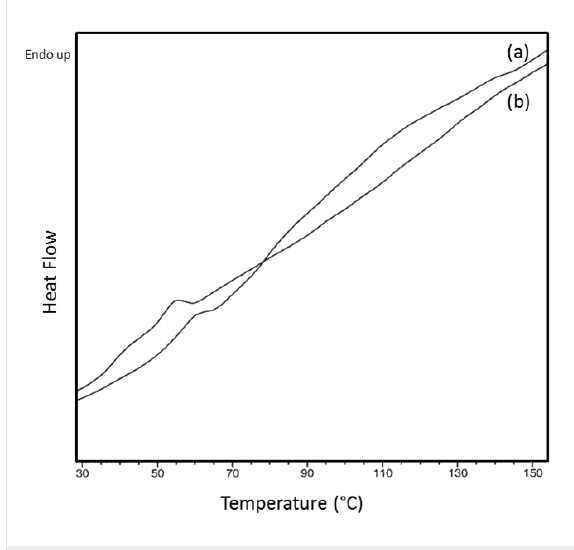
Figure 8: X-ray diffractograms of (a) pure PCL and (b) PLLA and PCL/ PLLA blends obtained by casting from dioxane solution (c) and hot- water coalescence from PCL/PLLA–CD IC (d) [16,25].